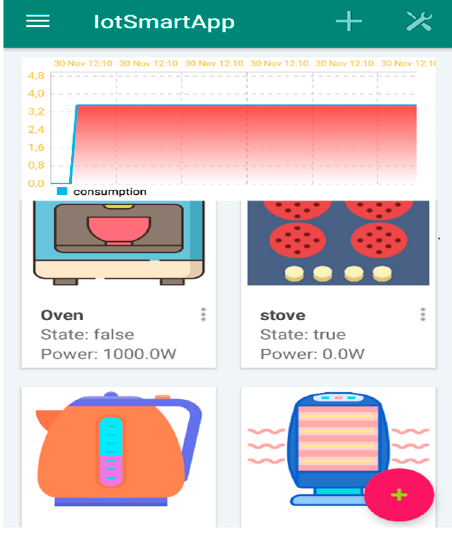
Figure 10. Energy consumption monitoring on IotSmartApp.